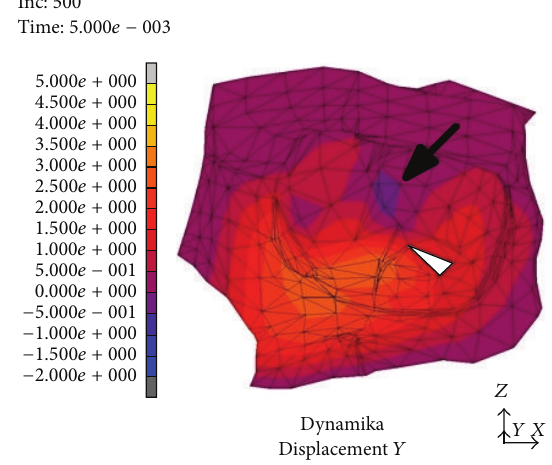
Figure 3: Dislocation after 𝑡 = 5⋅10 −3 s from the strike. Black arrow indicates the dislocation directed towards the inside of the orbit, the beginning of the “retrograde